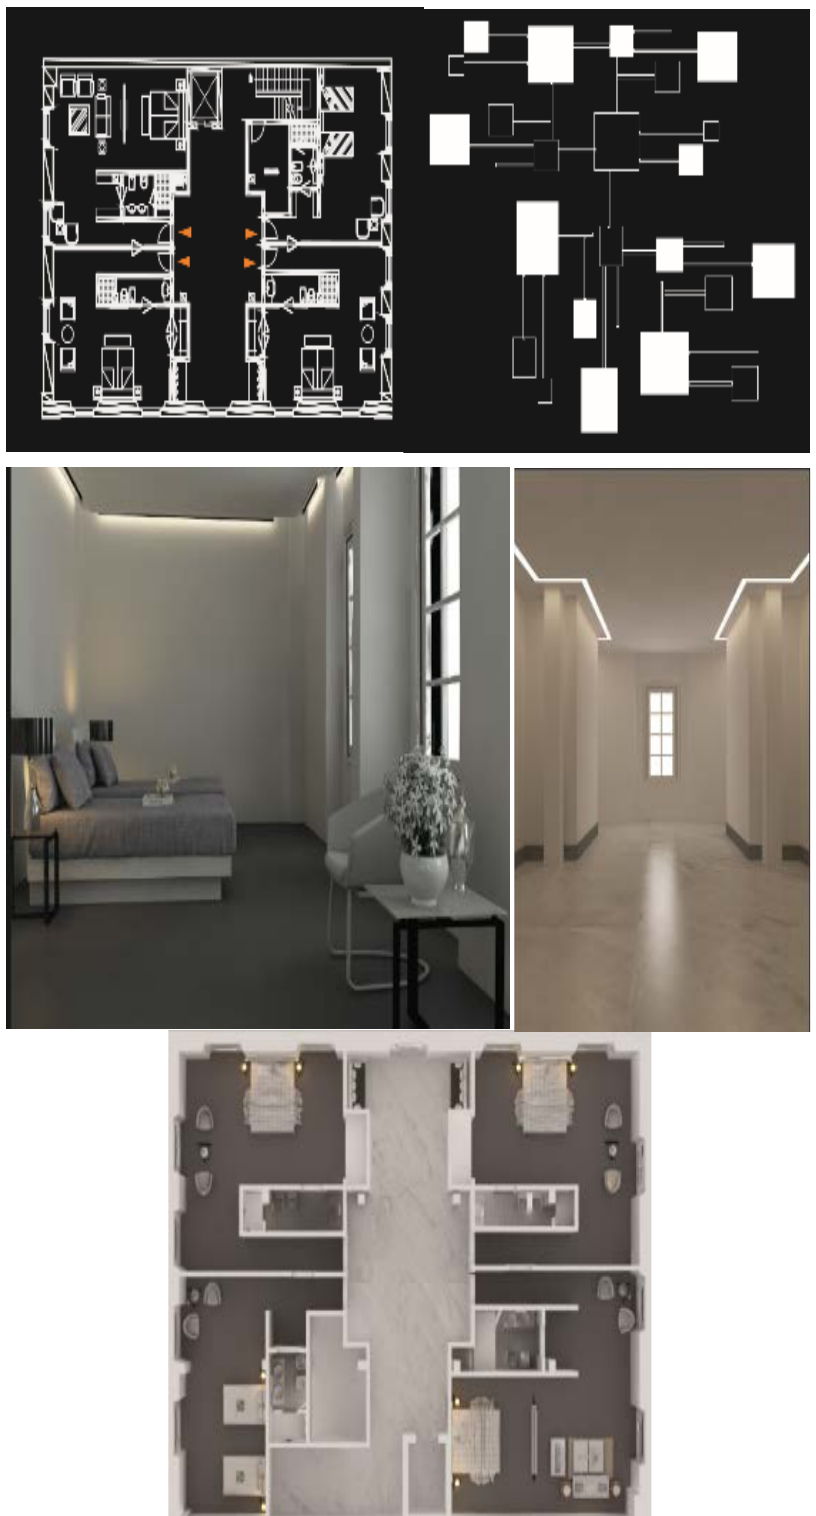
Figure 7 Photo Credits to Engineer Elnaz